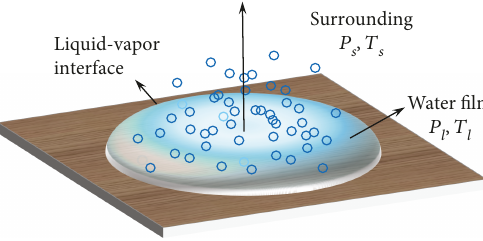
Figure 4: Film fl ash evaporation model.